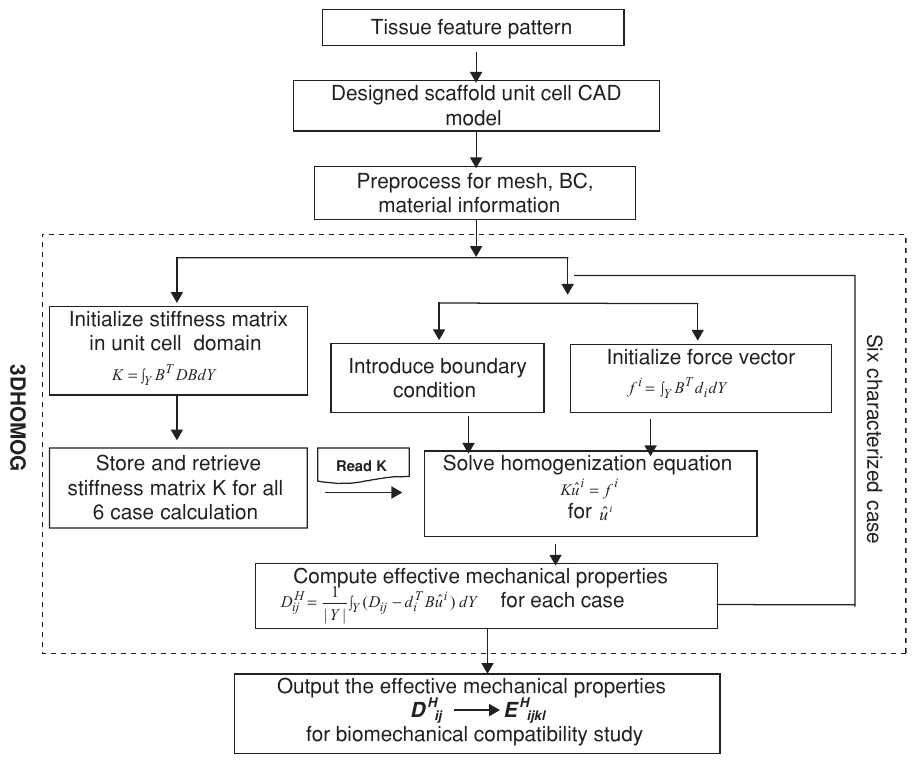
Figure 4 Functional flowchart of 3DHOMOG.